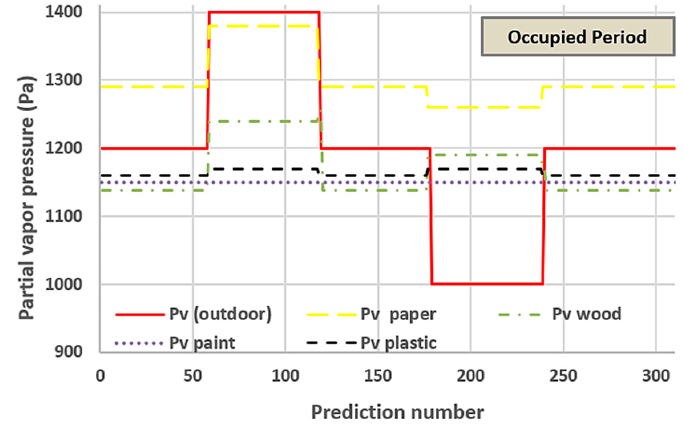
Figure 8. ANNs prediction of indoor and outdoor partial vapour pressure during the occupied period.